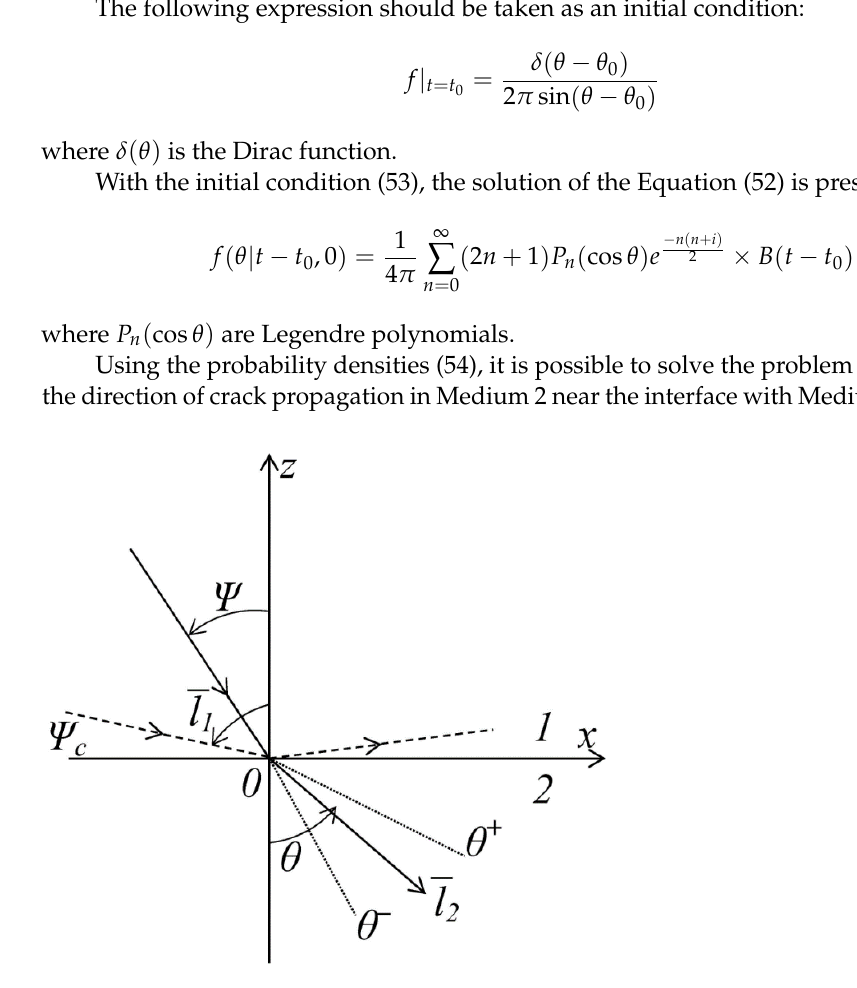
Figure 4. Diagram determining the direction of the crack propagation.